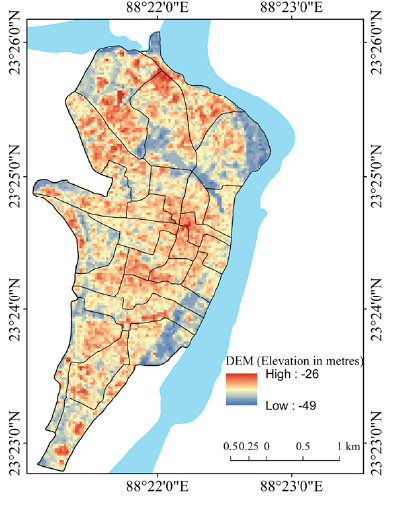
Figure 29. Relief (2015).